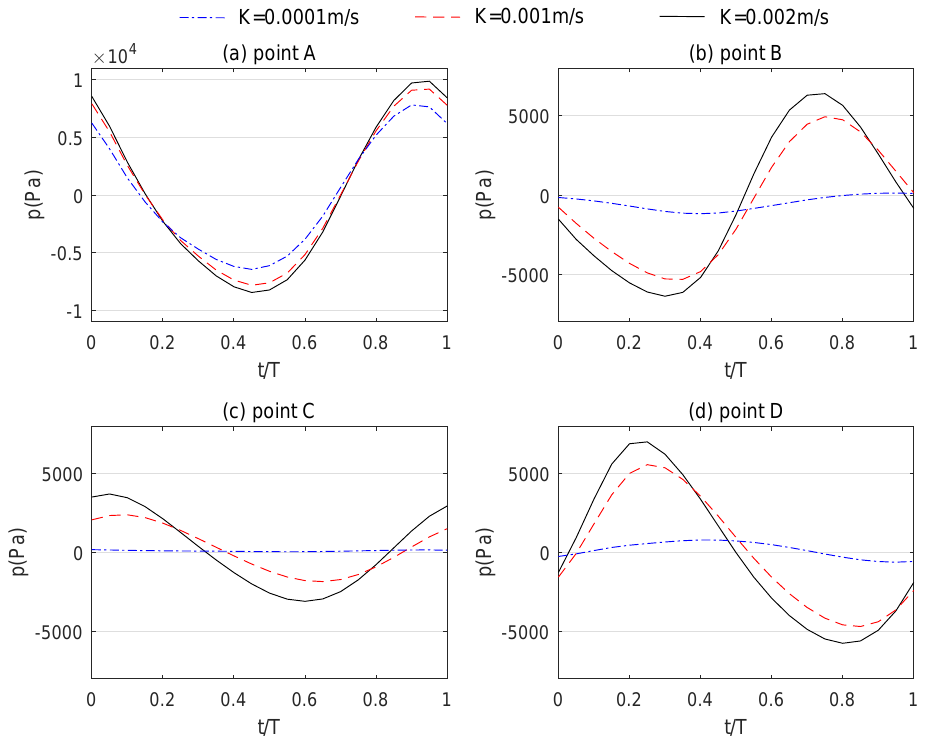
Figure 14. Distribution of the pore pressure over time in one period on four points with varied soil